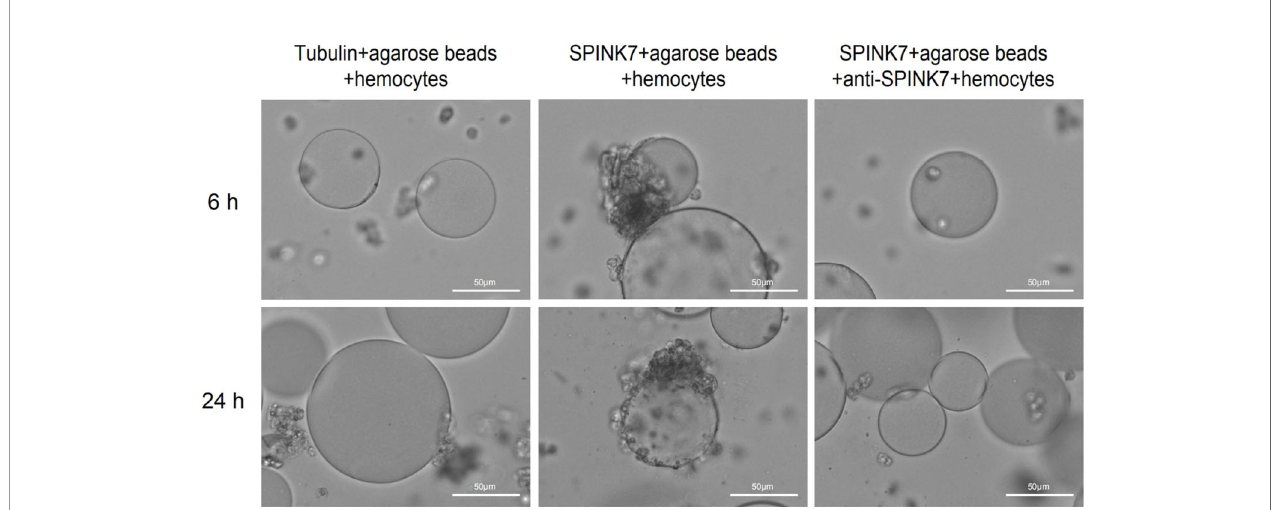
FIGURE 8 | Encapsulation and melanization of SPINK7-coated beads by hemocytes. Nickel agarose beads (80-100 beads) coated with SPINK7 or tubulin (as a control protein) were incubated with B. mori larval hemocytes. Encapsulation and melanization of the protein-coated beads were observed by microscopy after 6 and 24 h incubation. SPINK7-coated beads were encapsulated and melanized by B. mori hemocytes. Antibody speci fi c for SPINK7 blocks hemocyte encapsulation of the SPINK7-coated beads.